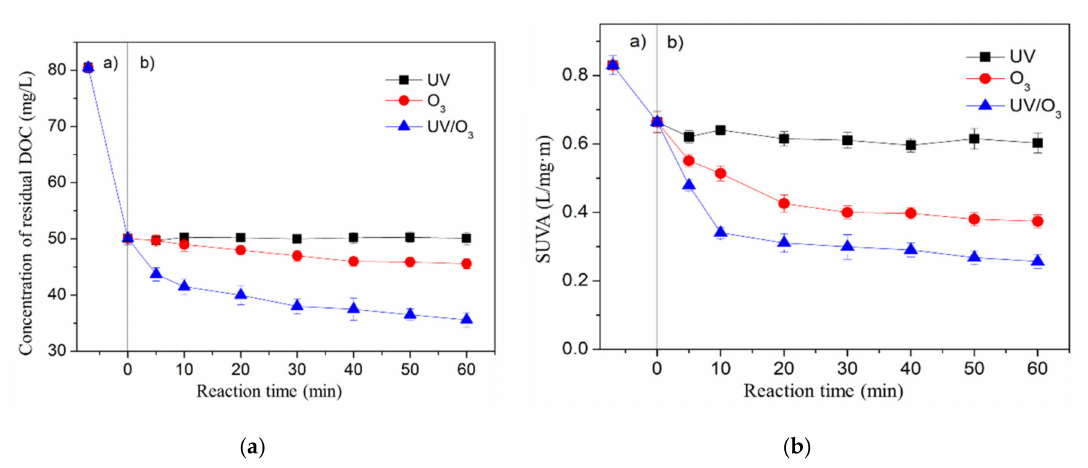
Figure 1. E ff ect of coagulation-UV, coagulation-O 3 and coagulation-UV / O 3 process on dissolved organic carbon (DOC) in pharmaceutical tail wastewater (PTW) ( a : coagulation stage; b : oxidation